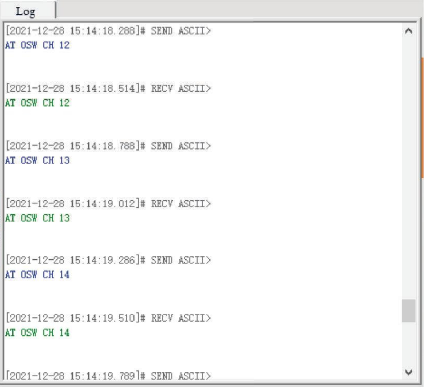
Figure 11: Monitoring diagram of link channel 3 by the platform without AI module.